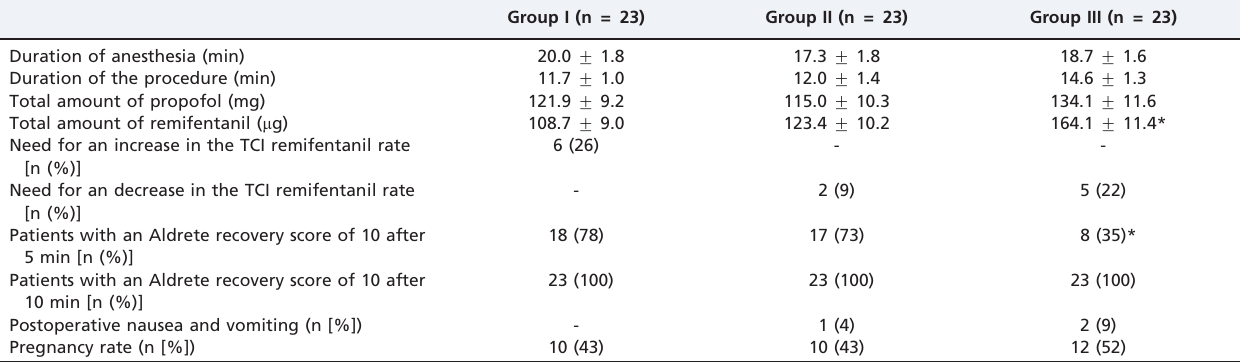
Table 2 - Data of anesthesia protocol and pregnancy